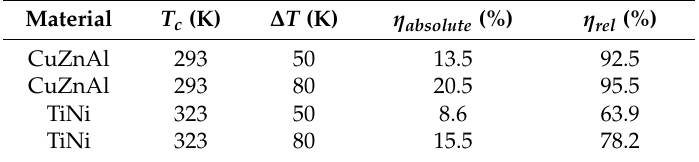
Table 3. Thermoelastic energy conversion efficiency of some of the SMA